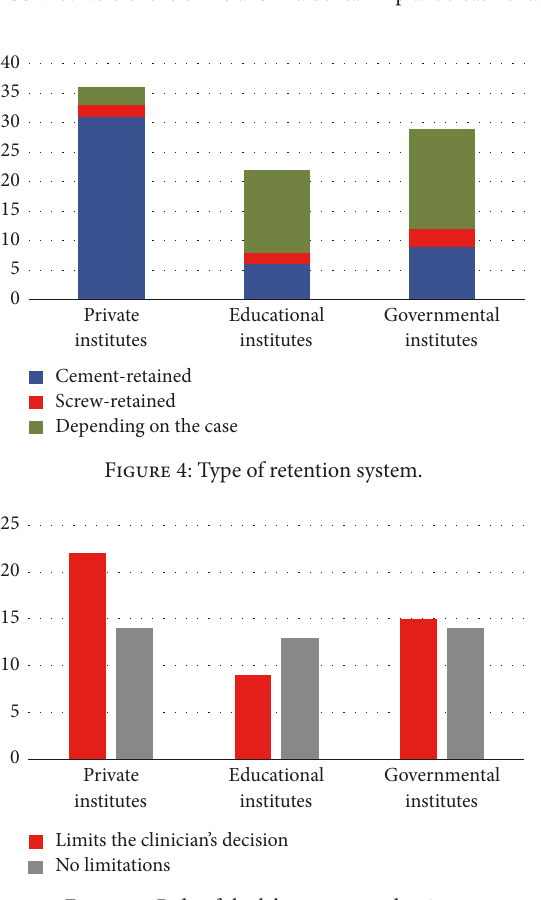
cure temporary filling, partially filled with cotton pellets.